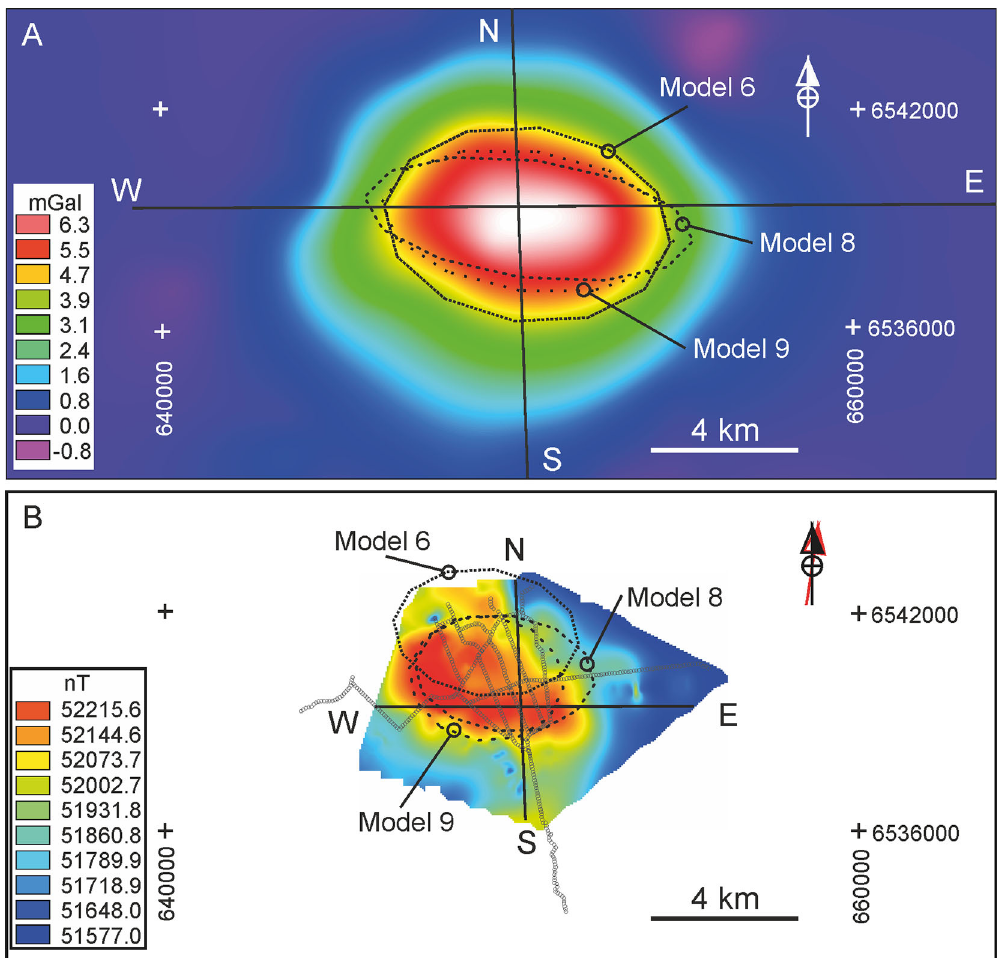
Fig. 3. Residual gravity anomaly map ( A ) and the total magnetic, intensity map over the Luusika area ( B ) with the location of the north–south and west–east profiles; ( B ) also features the position of ground-based magnetic survey points. Outlines of models are